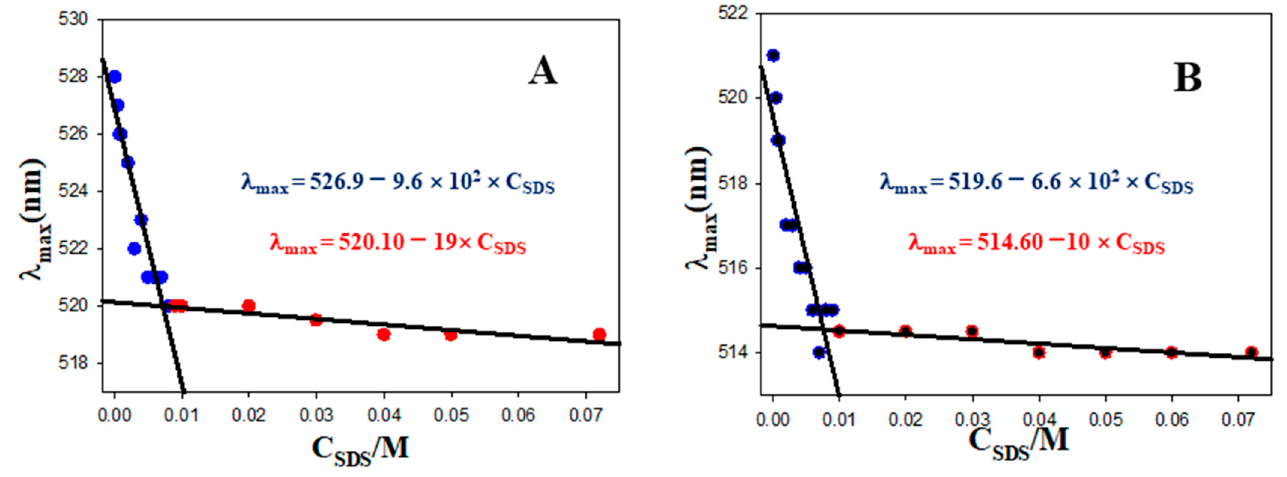
Figure 2. CMC determination for SDS surfactant following changes in maximum SPR wavelength.